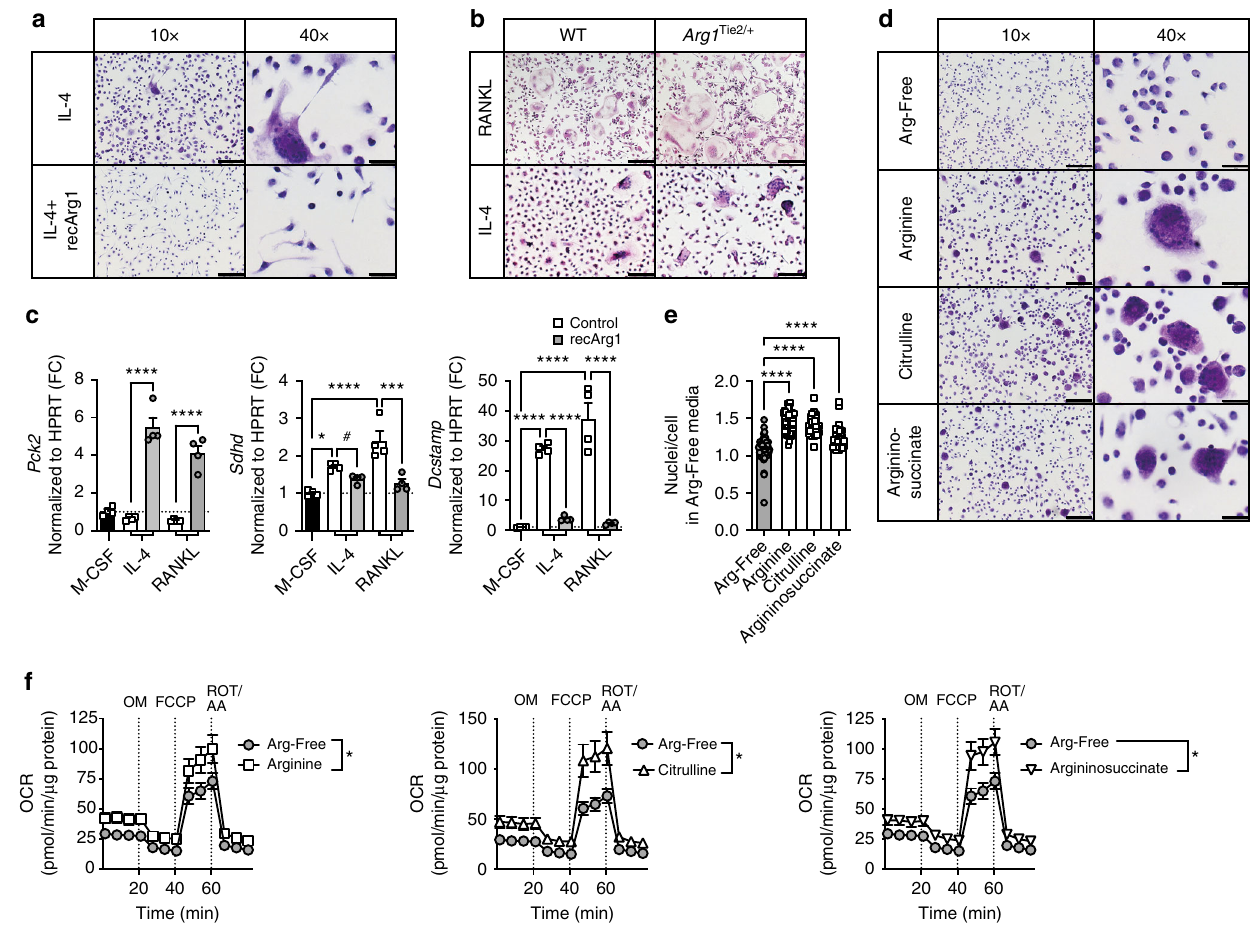
Fig. 7 Osteoclasts and IL-4-induced multinucleated giant cells (MGCs) share mechanisms of metabolic adaptation in nutrient scarcity. a Representative H&E stainings of MGCs ± recArg1. b Representative H&E stainings of MGCs from Arg1 Tie/ + and WT littermate controls. c qRT-PCR of Pck2 , Sdhd and Dcstamp in IL-4- (M-CSF + IL-4) and RANKL (M-CSF + RANKL)-induced MGCs ± recArg1. All data correspond to day 7, # corresponds to P = 0.01 assessed by t -test ( n = 4). d , e Representative H&E stainings ( d ) and quanti fi cations ( e ) of nuclei per cell of IL-4-generated MGCs in the absence of arginine (Arg-Free Media), re-supplemented with arginine, citrulline or argininosuccinate. Data represent cells counted in 50 random frames ( n = 50). f IL- 4-induced MGC oxygen consumption rate (OCR) in the absence of arginine (Arg-Free Media), re-supplemented with arginine, citrulline and argininosuccinate. Signi fi cance was calculated by unpaired t -test between area under the curve (AUC) of indicated conditions (Arg-Free n = 10, arginine n = 12, citrulline n = 11, argininosuccinate n = 11). Data are mean ± SEM, * P < 0.05, ** P < 0.01, *** P < 0.001, **** P < 0.0001, one-way ANOVA Tukey post- hoc test and t -test ( c ), one-way ANOVA post-hoc pairwise comparisons with Bonferroni correction ( e ) and two-way ANOVA post Sidak ’ s multiple comparisons test ( f ). Scale bar represents 200 µ m (10×), 50 µ m (40×) ( a , d ) and 200 µ m (RANKL) and 100 µ m (IL-4) ( b ). Source data are provided as a Source Data fi